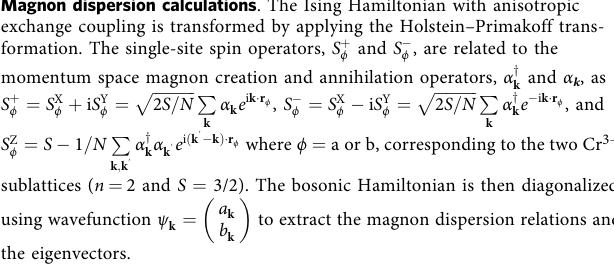
ffiffiffiffiffiffiffiffiffiffiffiffiffiffi p T (cid:2) T . The gray curve is the guide to the eye of C